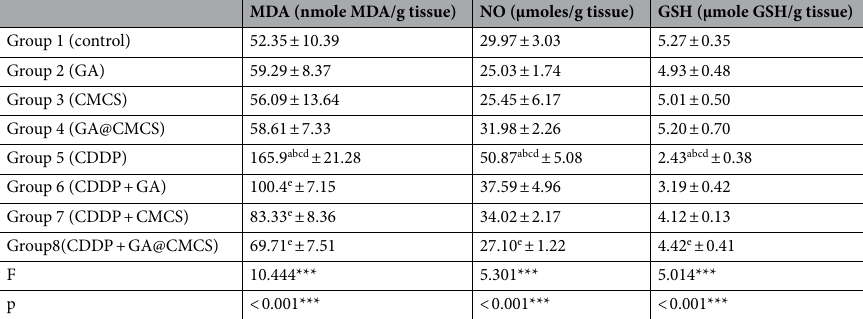
Table 2. Comparison of oxidative stress indicators and various parameters in renal tissues between different study groups. Data were expressed by using (Mean ± SE.), ( n = 8). F: F for the ANOVA test, pairwise comparison between every 2 groups was done using the Post Hoc Test (Tukey). p: p-value for comparing the different studied groups. a Significant with Group 1 (Control group). b Significant with Group 2 (GA group). c Significant with Group 3 (CMCS group). d Significant with Group 4 (GA@CMCS group). e Significant with Group 5 (CDDP group). ***Statistically high significance at p ≤ 0.001.